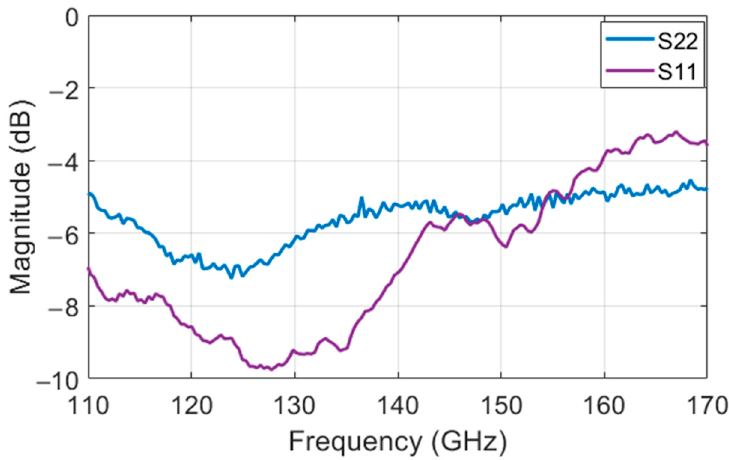
Figure 6. S11 and S22 for the modulator for different frequencies. A Keysight Advanced Design System (ADS) was used to simulate and estimate the RF output power for different LO input power levels. This relationship is plotted in Figure 7. The four different traces correspond to the four different PAM-4 data input power levels. The RF output power saturates around 5 dBm output power, according to this simulation. An LO input frequency of 130 GHz was used.